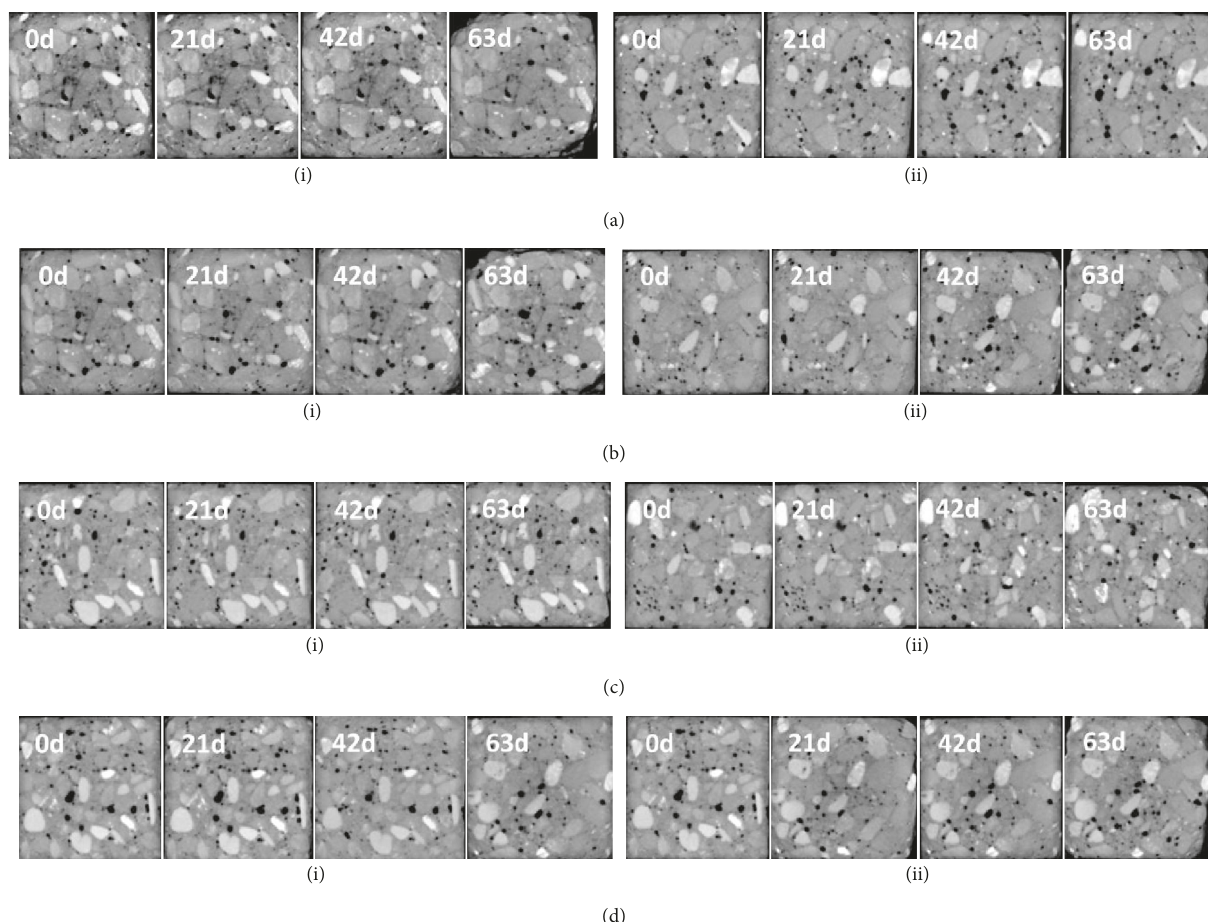
Figure 14: Cross-section CT images of DW-1 and DW-2 exposed to drying-wetting cycles with sulfate attack. (a) (i) Cross-section CT images of DW1-1 under different sulfate attack periods; (ii) cross-section CT images of DW2-1 under different sulfate attack periods. (b) (i) Cross-section CT images of DW1-2 under different sulfate attack periods; (ii) cross-section CT images of DW2-2 under different sulfate attack periods. (c) (i) Cross-section CT images of DW1-3 under different sulfate attack periods; (ii) cross-section CT images of DW2-3 under different sulfate attack periods. (d) (i) cross-section CTimages of DW1-4 under different sulfate attack periods; (ii) cross-section CT images of DW2-4 under different sulfate attack periods.